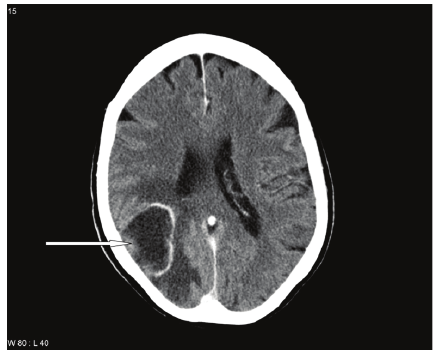
Figure 3: Contrast-enhanced computed tomography of the brain showing a 4.5cm large, partially necrotic brain metastasis with oedema (overall 5 metastases were